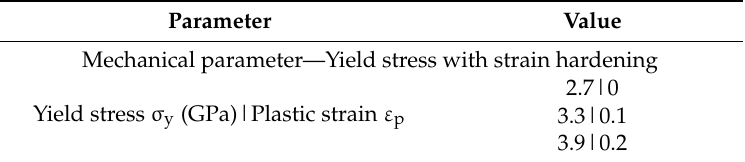
Table 7. Material strain-hardening parameters (close to the experimental response of the material) used instead of the concerned model in Table